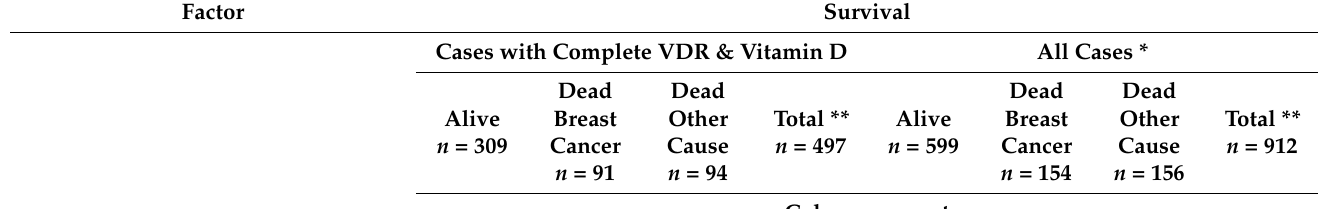
Table 3. Vital status in relation to age at diagnosis and prognostic factors for breast